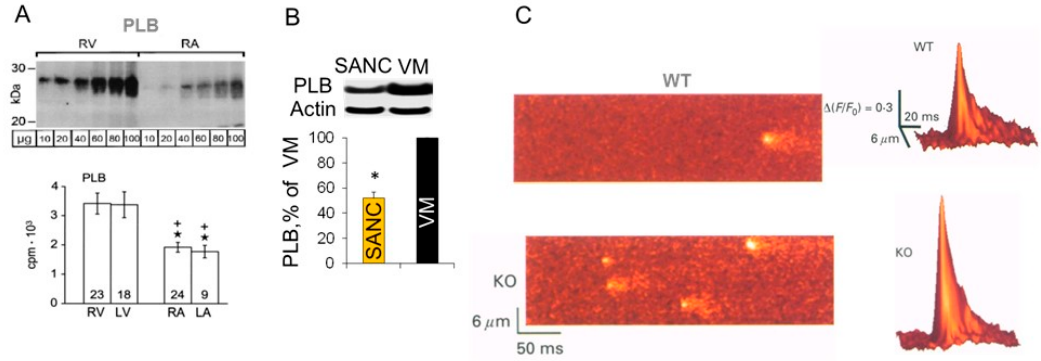
Figure 5. Comparison PLB abundance in SANC and ventricular myocytes. ( A ) Representative Western blot (top) and average data (bottom) showed that PLB is less expressed in human right (RA) or left (LA) atrium than in right (RV) or left (LV) ventricle (* p < 0.05 vs. RV, + p < 0.05 vs. LV, Bonferroni post hoc ANOVA; modified from Boknık et al. [75]). ( B ) Representative Western blot (top) and average data (bottom) showed that PLB was less abundant in rabbit SANC than in VM (modified from Sirenko et al. [35]). ( C ) Confocal line-scan images (left) and surface plots (right) of WT and PLB-KO mouse VM showed that spontaneous Ca 2+ sparks were three times more frequent and larger in amplitude in KO cells than that in WT (modified from Santana et al. [99]]). * Indicates statistical significance ( p < 0.05).